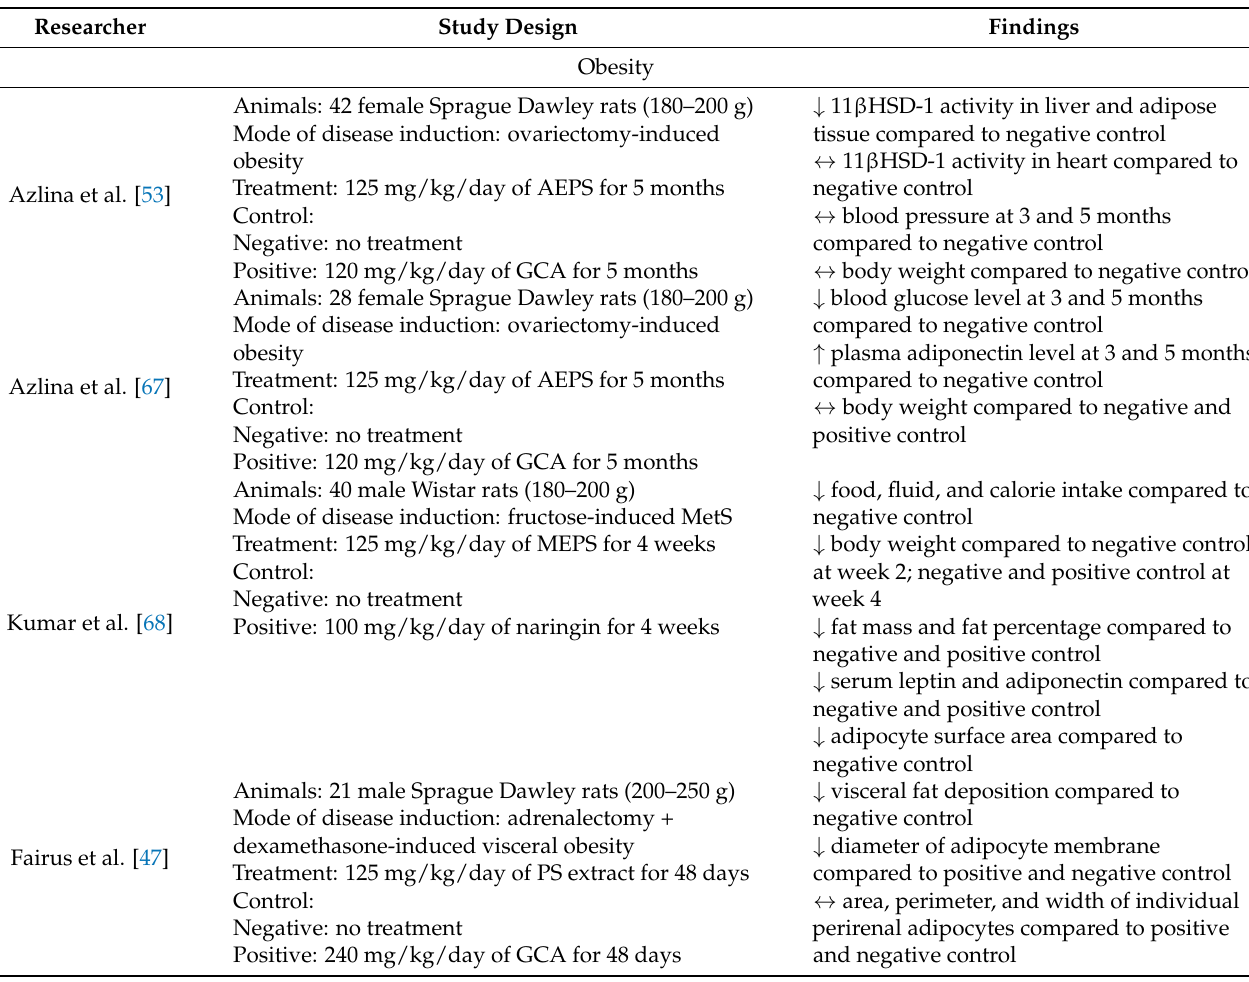
Figure 5. Protective effect of PS supplementation against dyslipidaemia/hyperlipidaemia: current knowledge and future area of investigation. List of abbreviation: PS, Piper sarmentosum ; ↑ , increase; ↓ , decrease; +, in combination; TG, triglyceride; TC, total cholesterol; LDL, low-density lipoprotein; HDL, high-density lipoprotein; HMGCR, 3-hydroxy-3-methyl glutaryl coenzyme A reductase. Table 1. Protective effect of PS against MetS